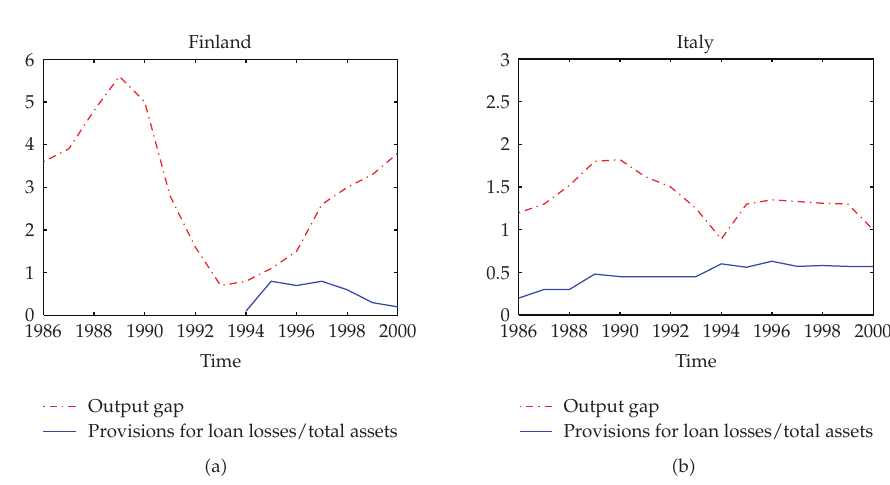
Figure 3: Output gap versus provisions for loan losses-to-total assets ratio for Finland and Italy (cid:2) 1986– 2000 (cid:3) .